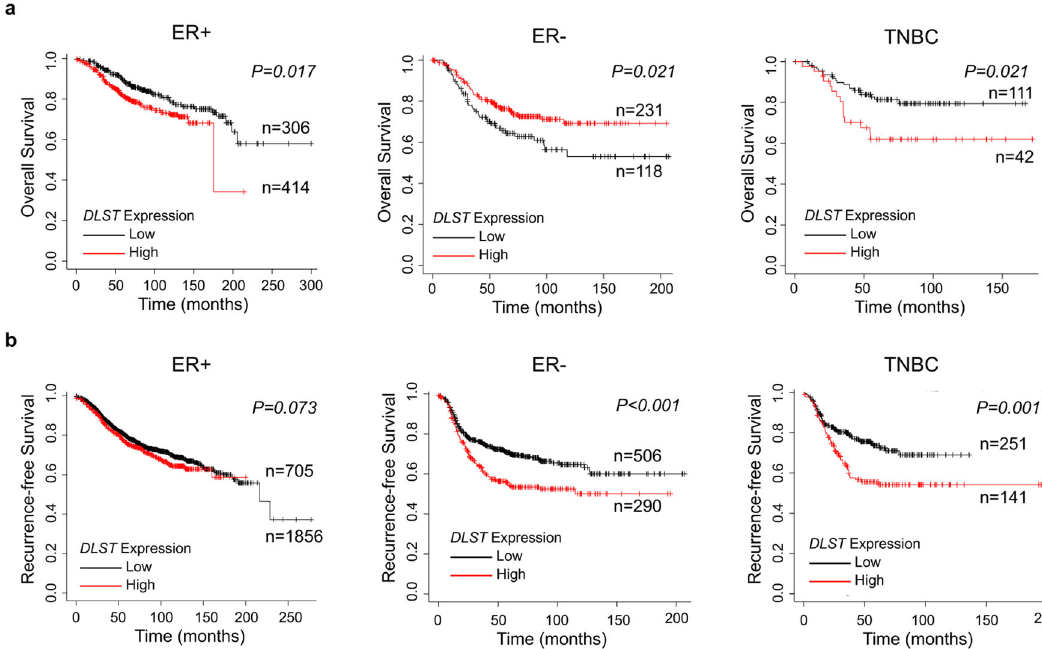
Fig. 1 High DLST expression is associated with poor overall and recurrence-free survival in TNBC patients. a , b In silico Kaplan – Meier analysis of the breast cancer patients (http://kmplot.com/analysis/). The curves demonstrate the association of DLST expression with overall ( a ) and recurrence-free ( b ) survival in patients over time. Overall survival: n = 720 for ER + , n = 349 for ER − , and n = 153 for TNBC; and recurrence-free survival: n = 2561 for ER + , n = 796 for ER − , and n = 392 for TNBC. Patient samples were strati fi ed using the best cut-off and compared with the log-rank test for statistical signi fi cance between